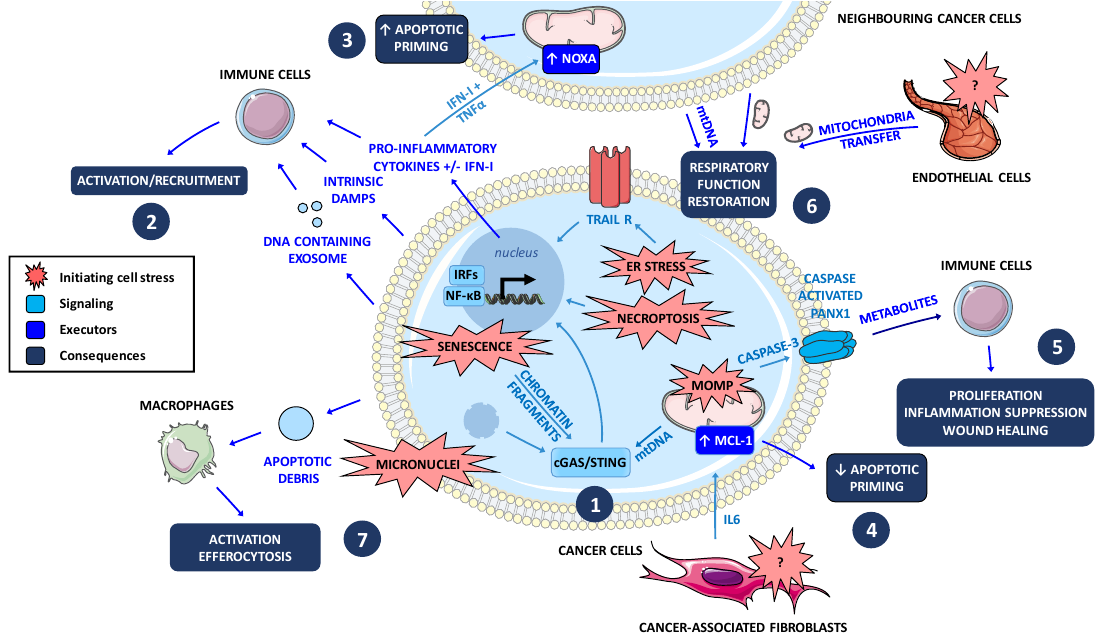
Figure 4. Intrinsic cancer cell response and intratumoral dialogue induced by chemotherapies. 1. Senescence-dependent chromatin fragments, antimitotic-induced micronuclei or MOMP-released